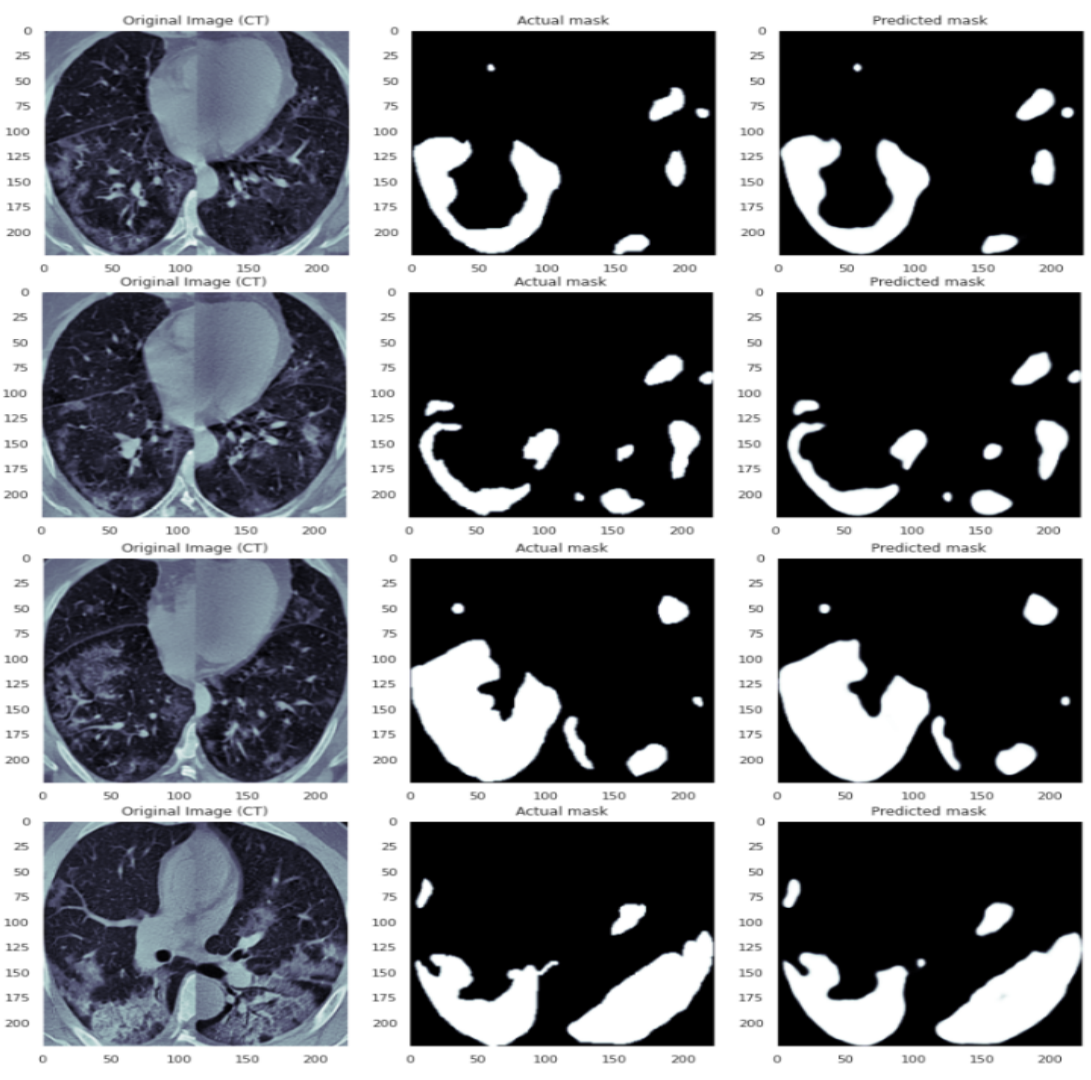
Figure 14. Visual qualitative comparison of the infection segmentation results between the ground truth and our proposed model on four slices from different CT scans. First column: original CT scan. Second column: ground truth. Third column: predicted infection masks.